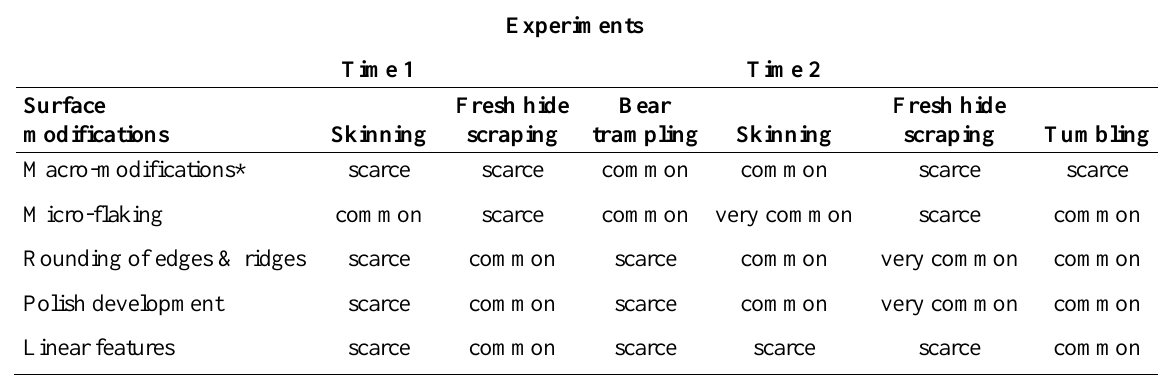
Table 2. Summary of relative presence of the main wear features taken into account for skinning, fresh hide scraping, trampling and tumbling experiments at time 1(20 minutes of use and 3 month of bear trampling) and time 2 (total of 50 minutes of use and 20 hours of tumbling). *By ‘macro modifications’ we refer to macroscopically visible edge damage or fractures and patina formation.